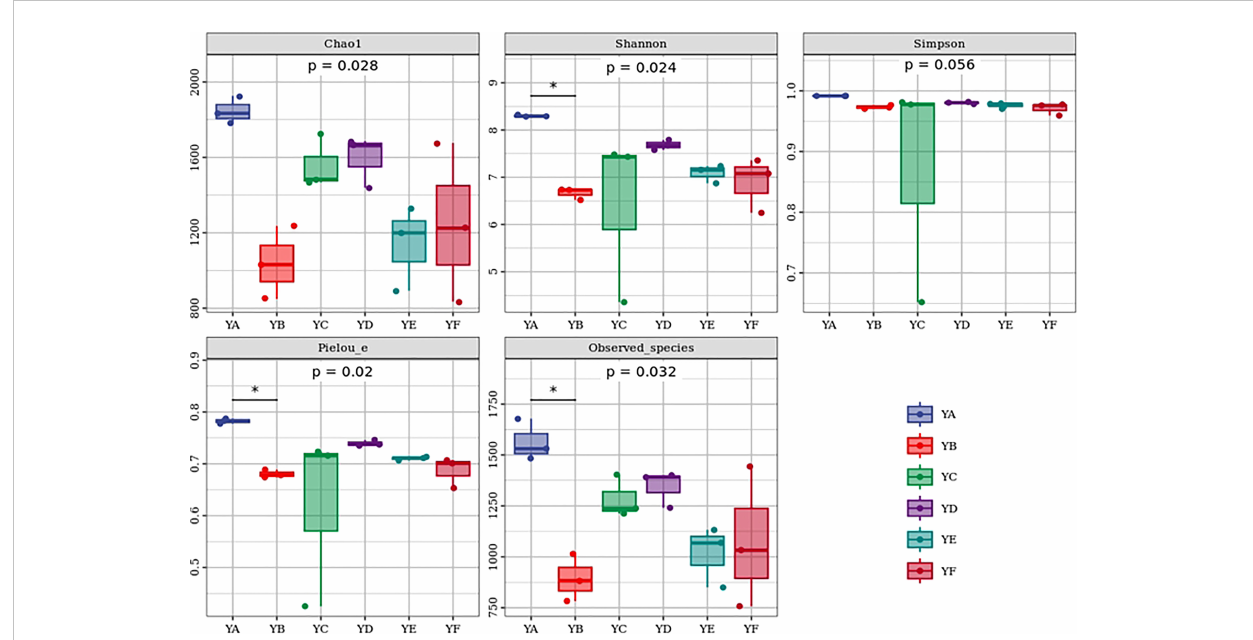
FIGURE 2 Box plot of alpha diversity of phyllosphere bacterial communities of different species of Populus spp.* indicated p < 0.05 by dunn ’ test as a post-hoc test. YA: Populus × euramaricana ‘ Bofeng 3 hao ’ ; YB: P.deltoides ‘ Shanghaiguan ’ × P. deltides ‘ Harvard ’ ; YC: P.nigra ‘ N46 ’ : YD: P.nigra ‘ N102 ’ ; YE: P. × euramericana ‘ Guariento ’ ; YF: P. alba × P.glandulosa ‘ 84k ’